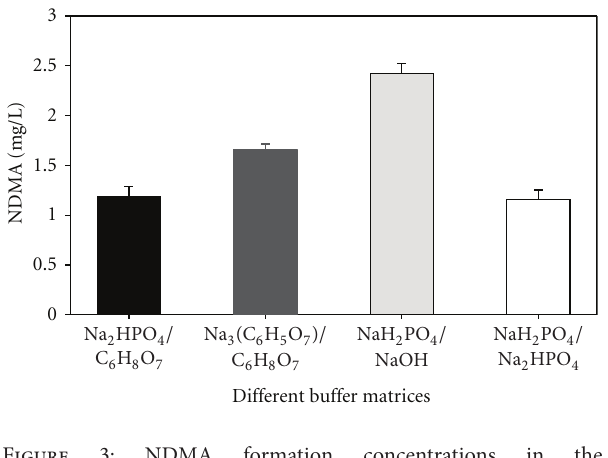
Amounts of the addition of components (mmol ⋅10 −3 ) NDMA formation concentrations in the in the reaction of 10mM DMA and 4mM NaNO /NaOH, 2 buffer solutions (pH = 6.4). Reaction time F 4: NDMA formation in the presence of variable amounts and Na ) addition; 4h reaction; 90 C. e of NaH pH was maintained at 6.4 with 2